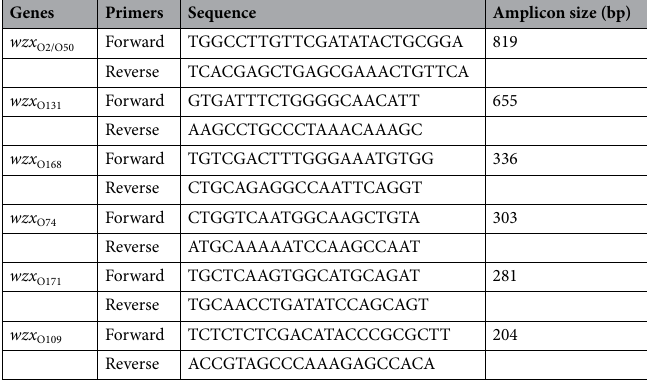
Table 6. Target genes, primer sequences, and amplicon sizes of the six-plex PCR